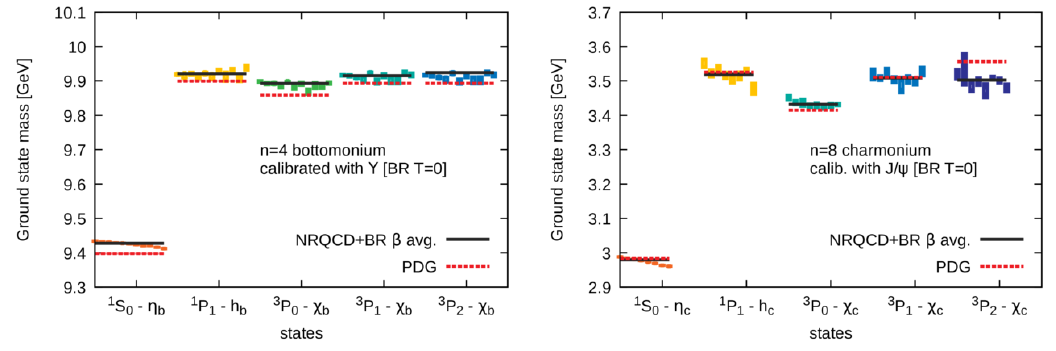
Figure 9 . Compilation of the ground state masses obtained from the BR method at zero temper- atures, the bottomonium results being plotted on the left, the charmonium results on the right. Error boxes denote the statistical uncertainty, while error bars correspond to the default model dependence of the